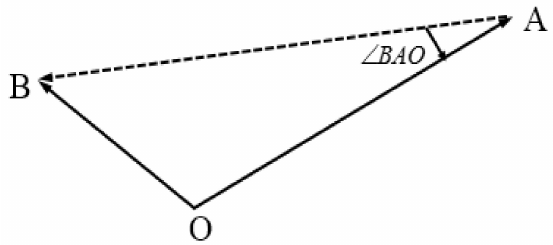
Figure 3. Vibration vector